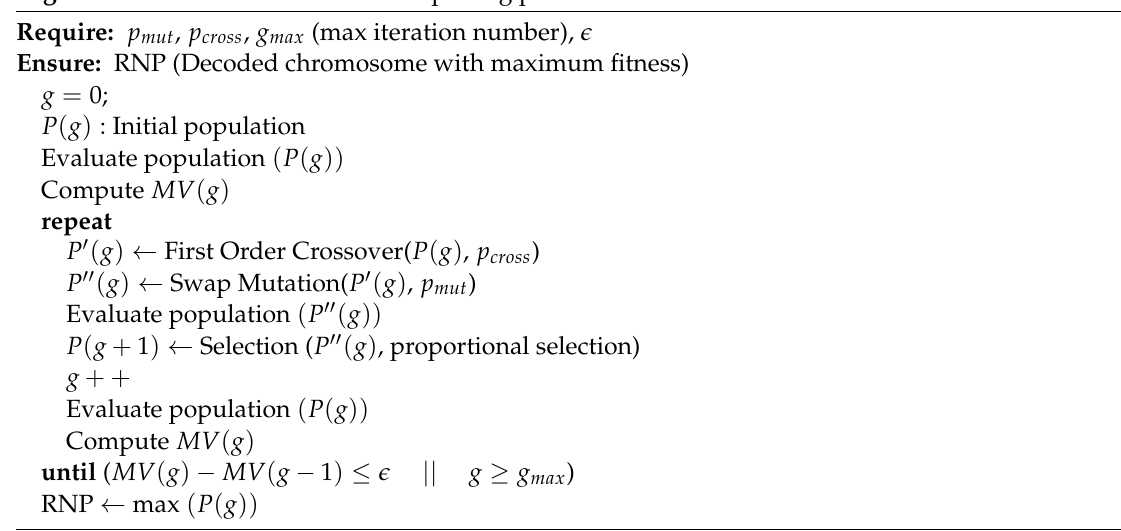
Algorithm 3 GA for the reliable node placing